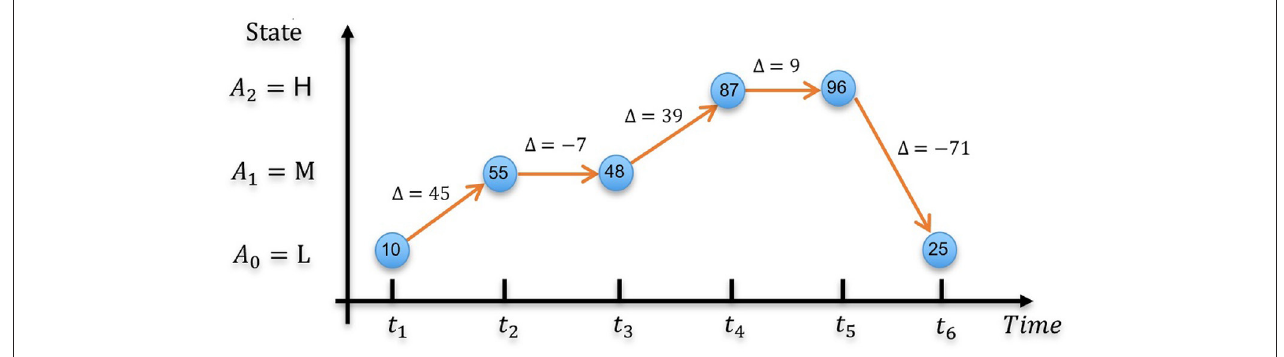
FIGURE 2 | A graphical representation of the complementary characteristics of AOLs and ROLs over 6 time steps within a 100-frame utterances. The position of the blue circles represents AOLs at different time steps with ROLs indicated by the number insides the circles, and the arrows depicting ROL changes between consecutive time